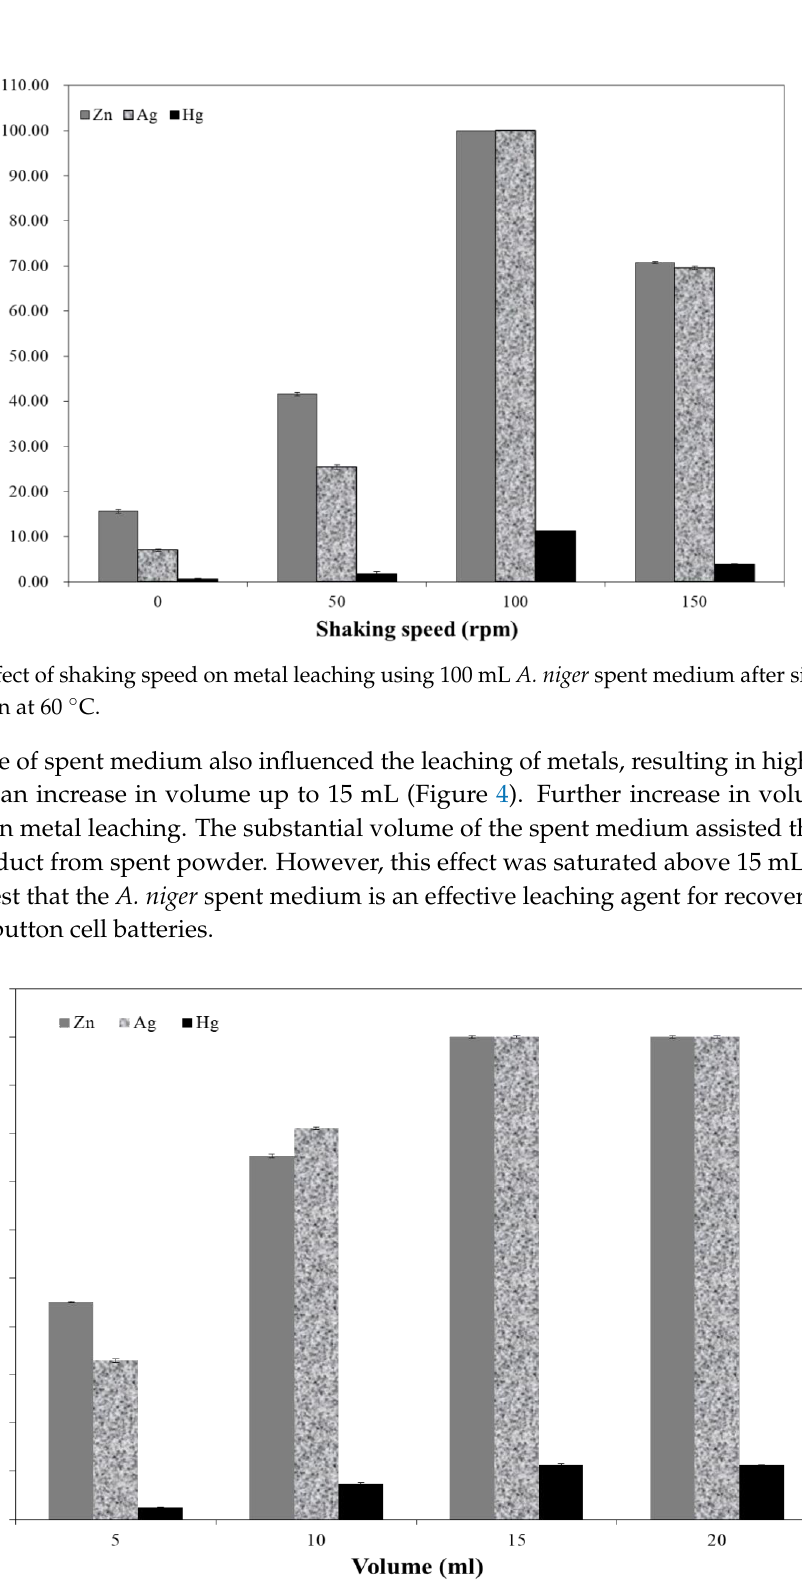
Figure 4. Effect of A. niger spent medium volume on leaching of metals after six hours of incubation at 60 °C and 100 rpm.